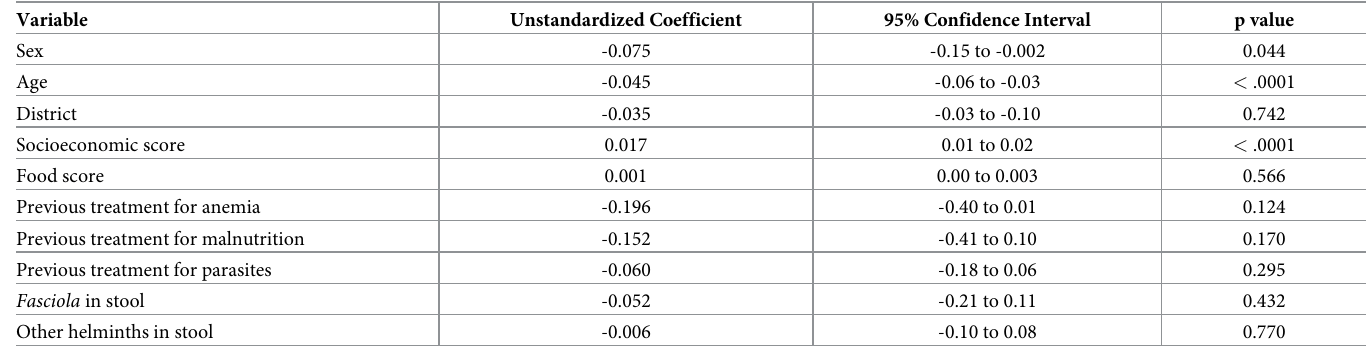
Table 3. Multiple regression analysis of factors associated with Height for Age Z